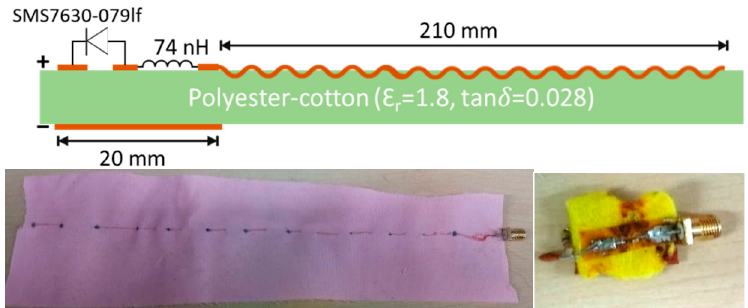
Figure 1. ( top )The fabricated rectenna layout (not to-scale). ( bottom ) Photograph of the sewn an- tenna ( left ) and rectifier ( right ), on a poly-cotton and a felt substrates respectively. The proposed antenna has been fabricated on a polyester-cotton substrate ( Ԑ r =